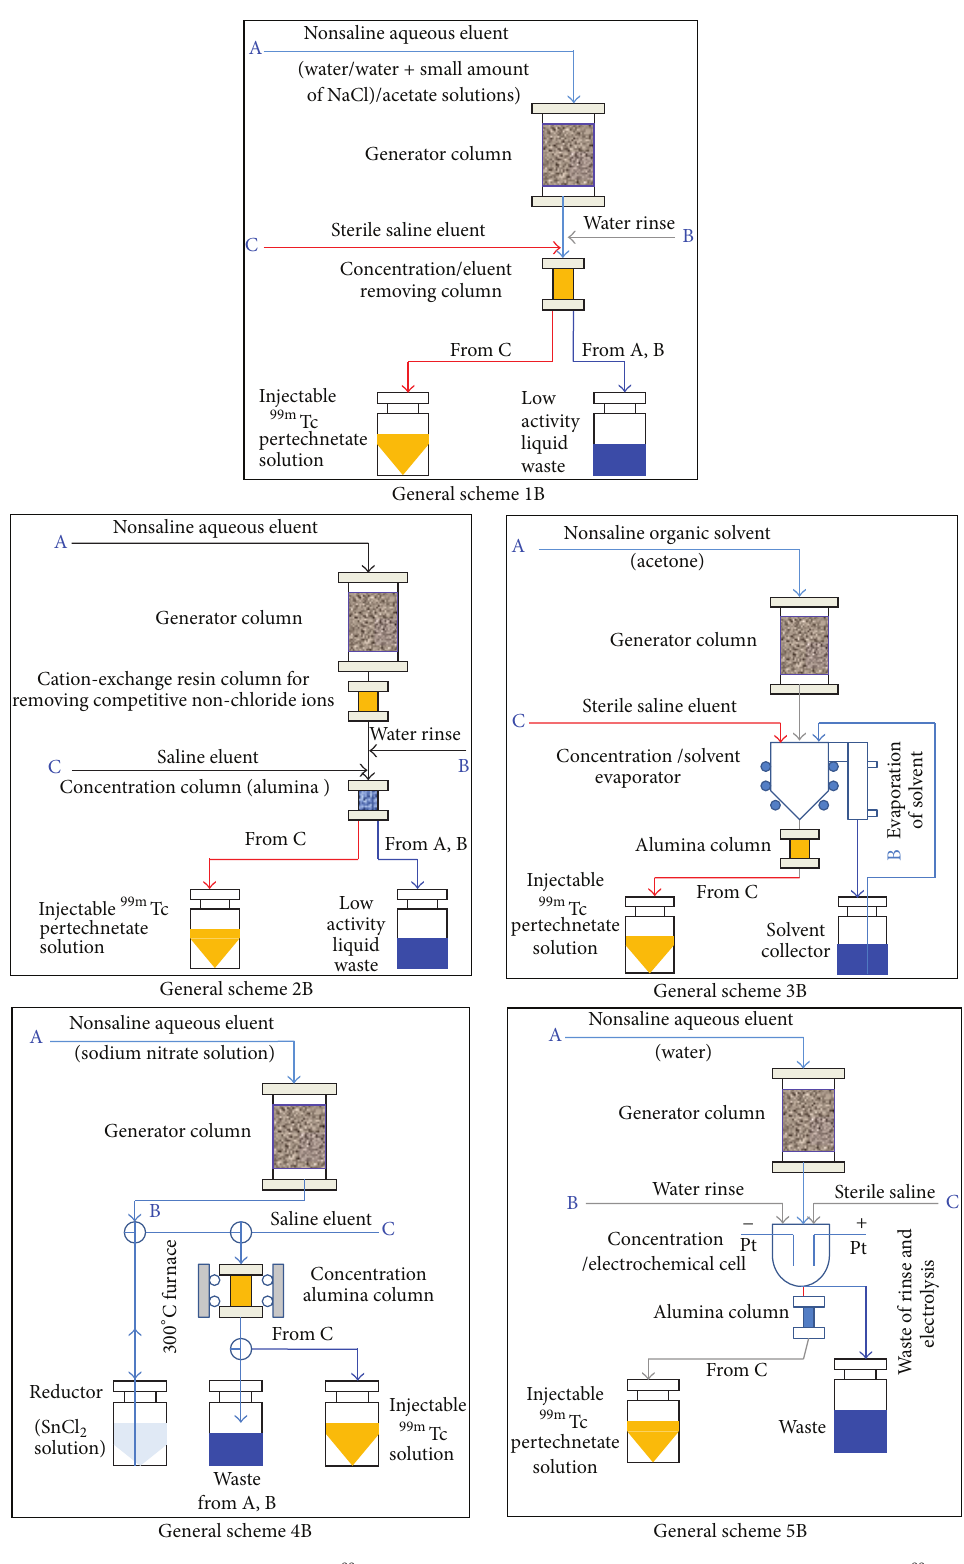
Figure 20: Group 2 of concentration methods: 99 m Tc-pertechnetate concentration from nonsaline eluate of the 99 m Tc